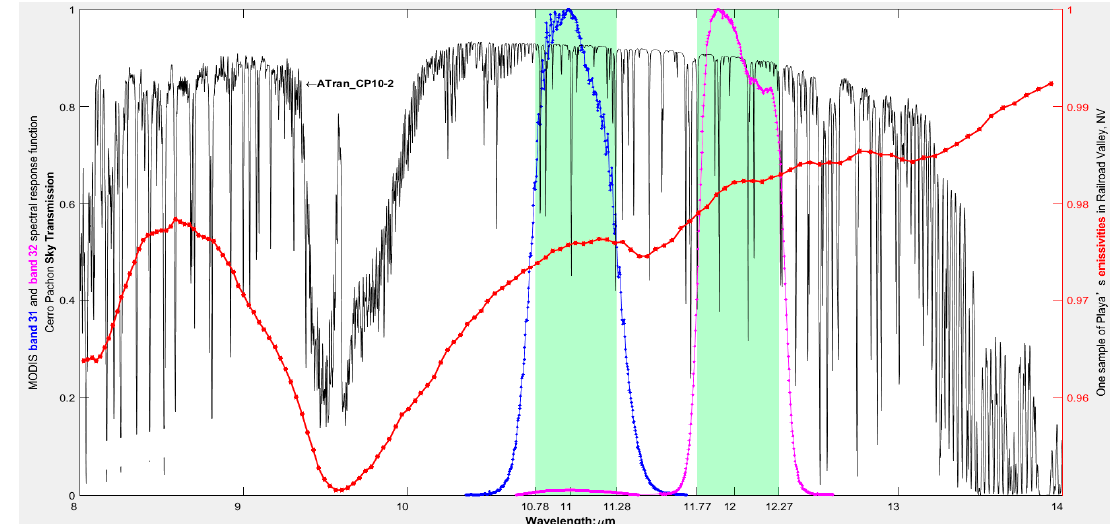
Figure 3. The spectral response functions of M31 and M32, one emissivity sample of the playa surface in Railroad Valley, Nevada, US and one sample of the exceedingly dry and stable atmospheric transmittance in Cerro Pachón, Chile used in our numerical experiments (34).